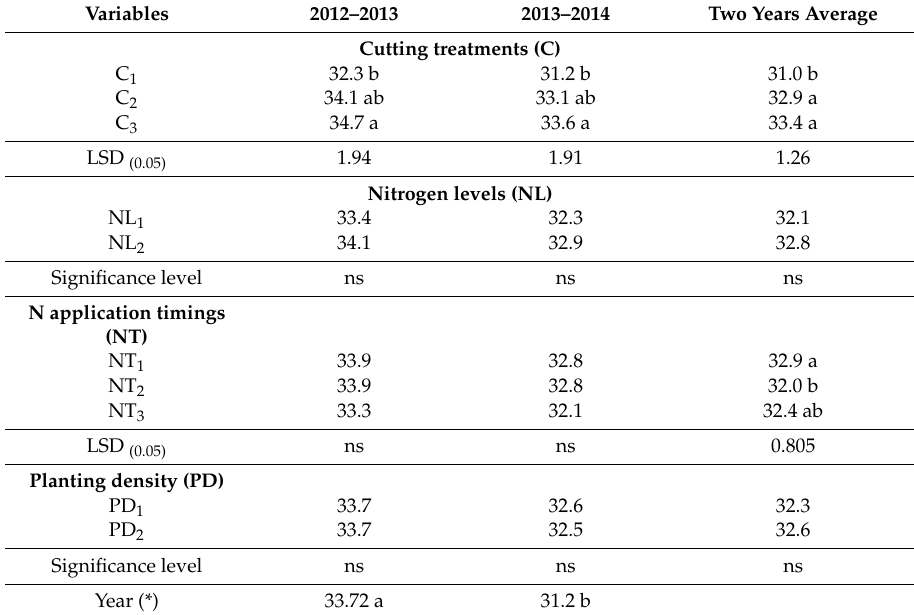
Table 7. Erucic acid (%) canola as a ff ected by cutting treatments, nitrogen levels and application timings under varying planting densities.